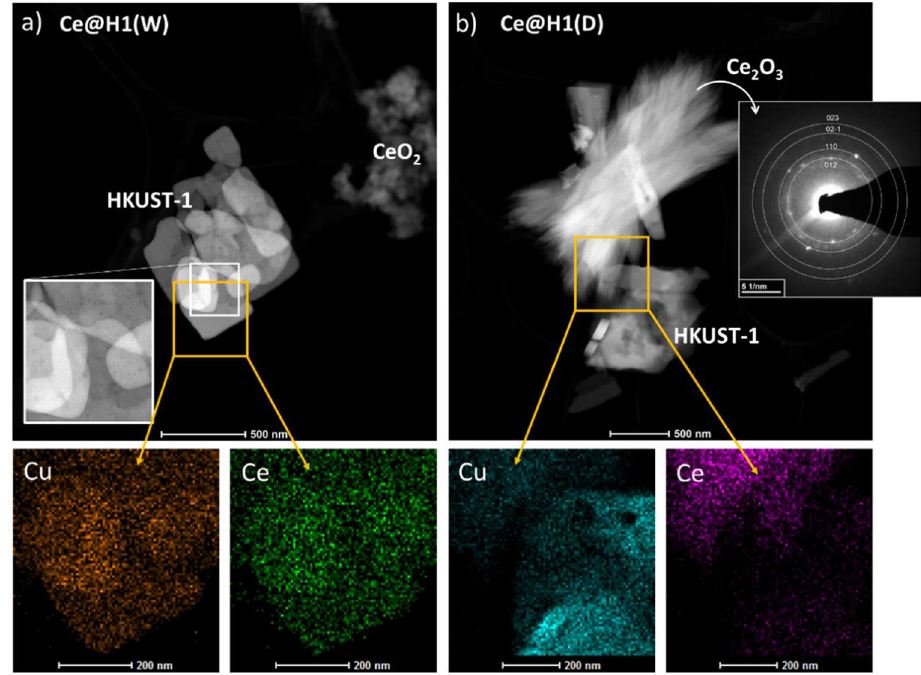
Figure 4. High-angle annular dark-field imaging (HAADF-STEM) images of Ce@H1(W) (a) and Ce@H1(D) (b) with marked area of Cu and Ce EDS maps. The SAED electron diffraction of Ce 2 O 3 in Ce@H1(D) is shown on the right side of ( b ).